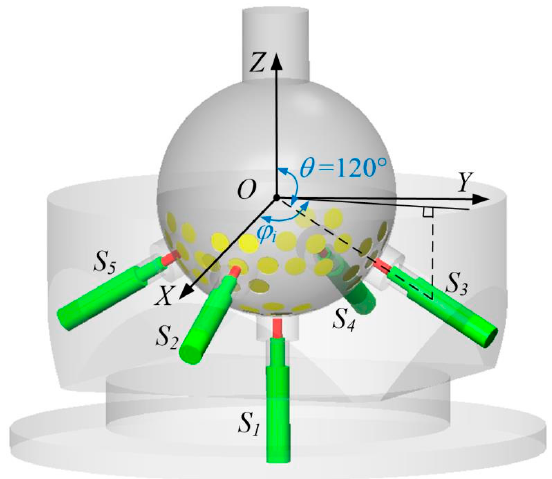
Figure 5. Arrangement of the hole array.